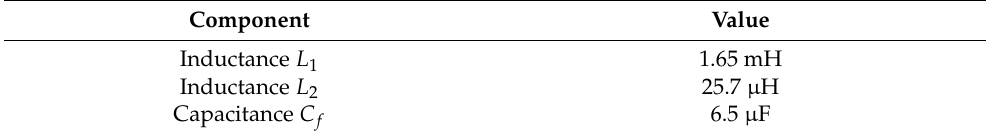
Table 2. LCL filter parameters.